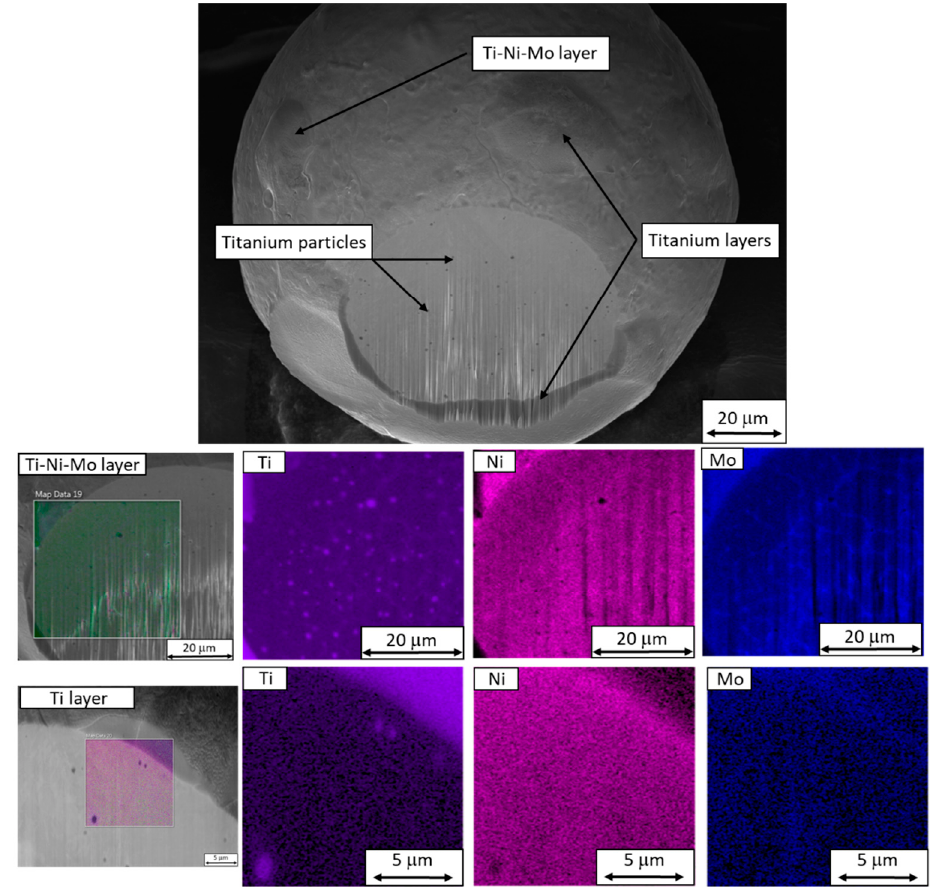
Figure 12. EDS maps of a reused powder particle showing the differences between a Ti-layer and a Ti-Ni-Mo layer. Titanium particles and molybdenum segregation in the cellular structure can be seen.